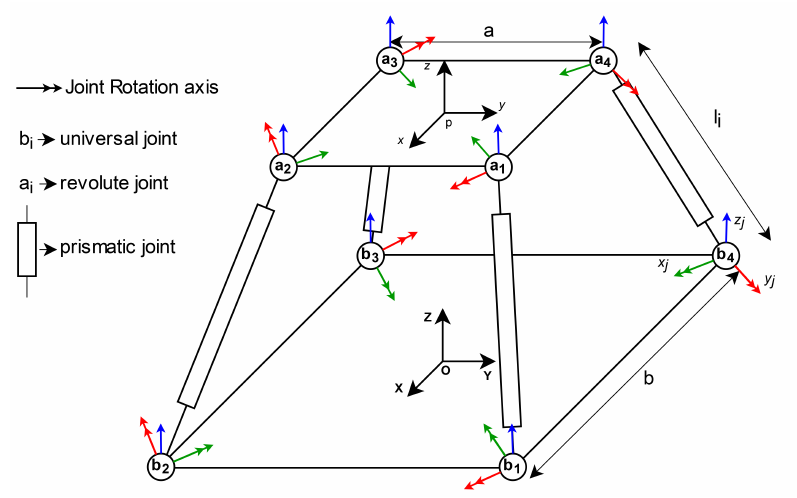
Figure 3. The 4-UPR platform mechanism schematics. The top and bottom joints of the platforms form a square with side a and b ,